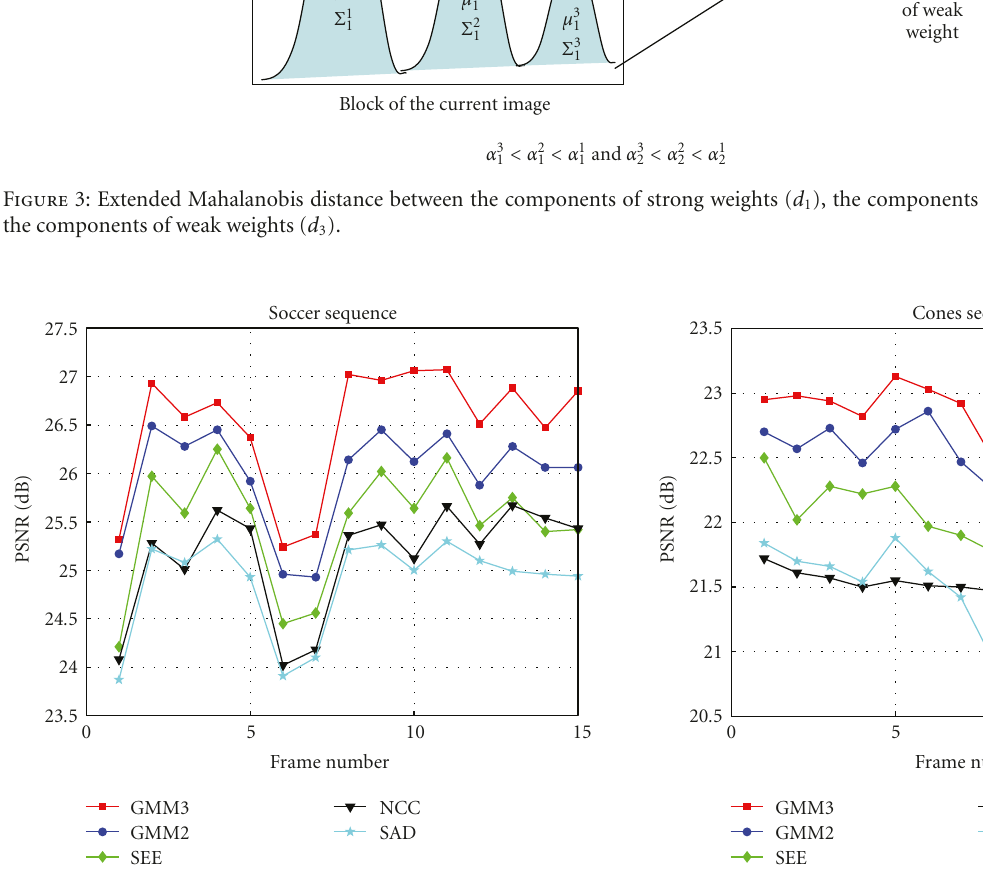
Figure 4: PSNR comparisons of GMM3, GMM2, SAD, SSE, and NCC algorithms for the “Soccer” sequence without influence of noise.